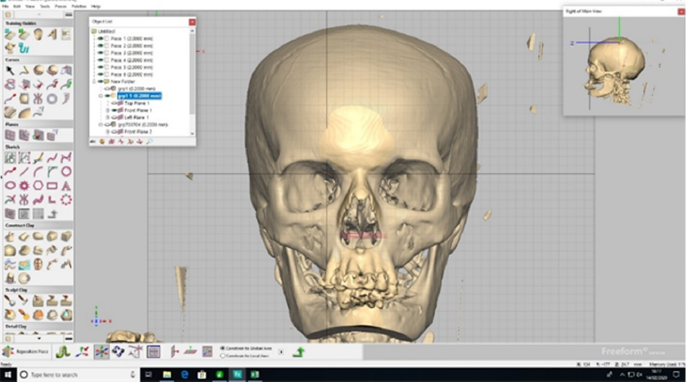
Figure 1. Distance between the most lateral points of the nasal aperture. Appl. Sci. 2020 , 10 , x FOR PEER REVIEW